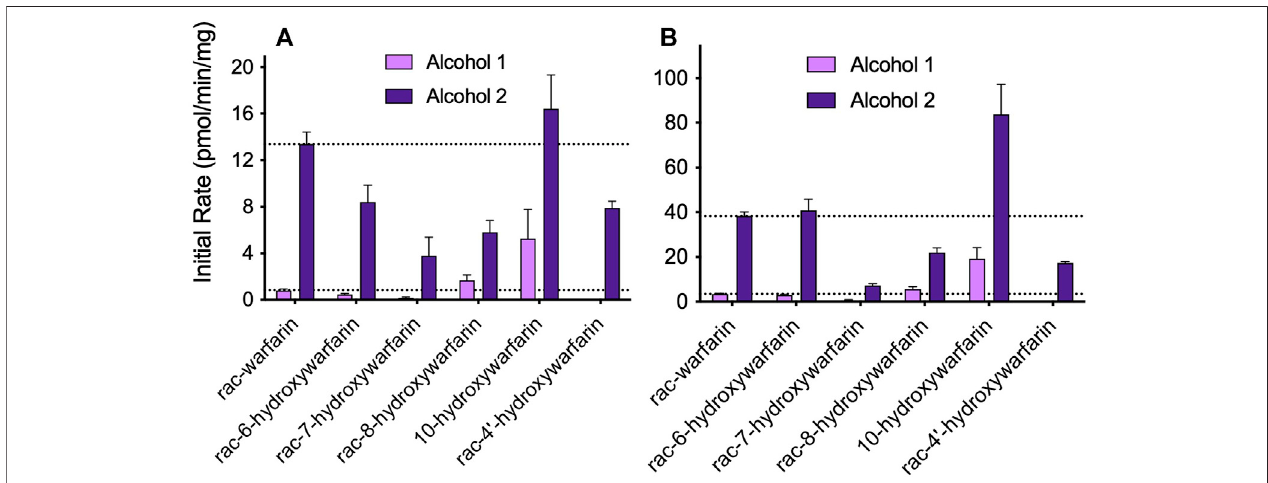
FIGURE3| Screeninghydroxywarfarinsforreduction byhumanlivercytosol.Initialreactions werecarriedoutwith1.0 mg/ml proteinhumanlivercytosolin50 mM potassium phosphate pH 7.4 with either (A) 100 or (B) 1,000 μ M rac -warfarin (positive control) or rac -hydroxywarfarin. Reactions yielded alcohol 1 (minor metabolite, light purple) and alcohol 2 (major metabolite, dark purple), although the reaction for rac -4 ′ -hydroxywarfarin generated only alcohol 2.